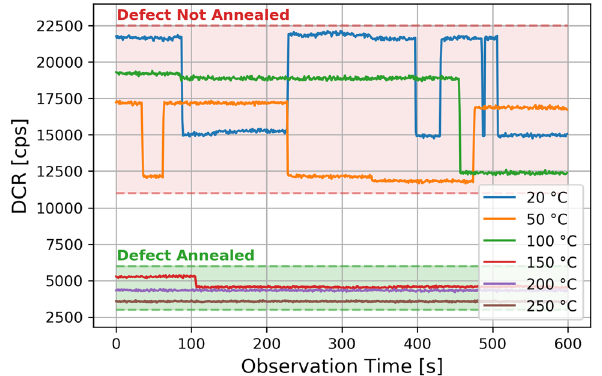
Figure 12. Evolution of a two-level RTS during